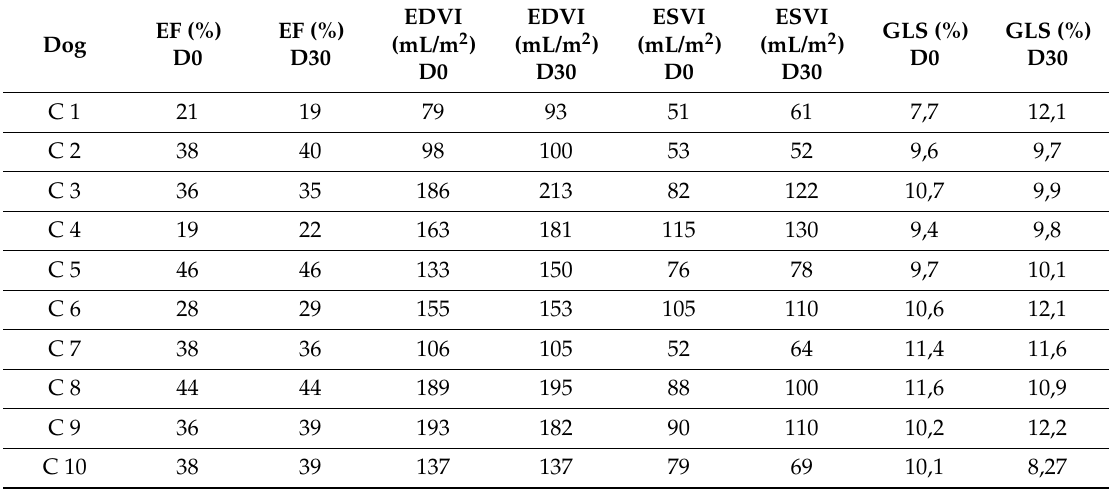
Table 3. Echocardiographic parameters (standard and strain) recorded at D0 and D30.